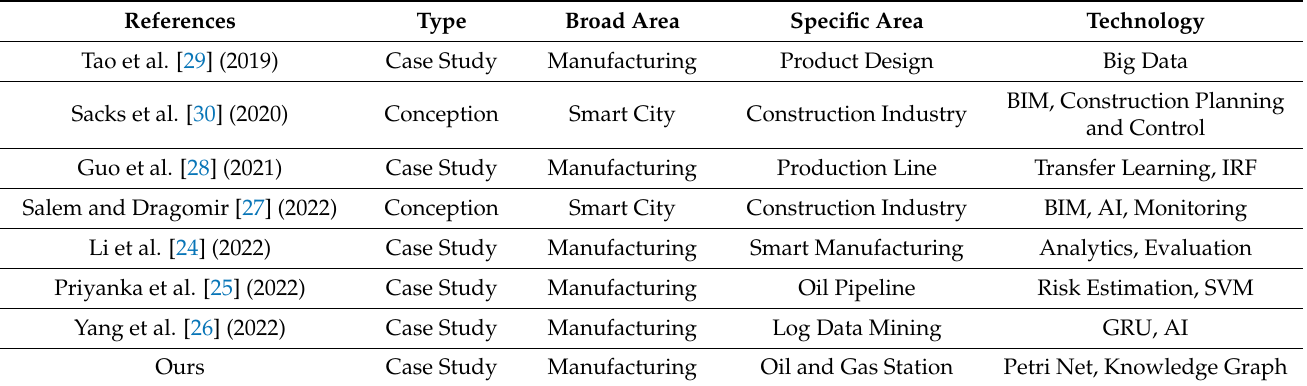
Table 1. A Comparative Study for Digital Twin in open